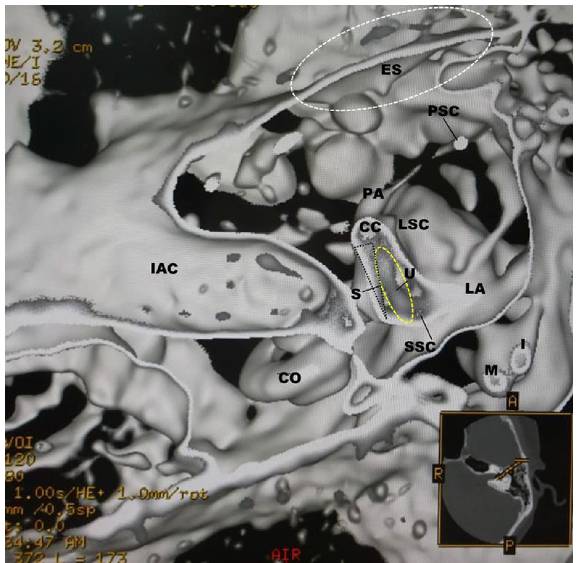
Figure 6. MD in a 58-year-old female. In the axial view, the utricular macula (yellow dotted oval) is in the shape of an elongated pea and connected to the exit of the lateral semicircular canal. The expanded saccular macula (black dotted triangle) is visible from the superior axial view. U utricular macula (yellow dotted oval), S saccular macula (black dotted triangle), LA lateral ampulla, LSC lateral semicircular canal, PA posterior ampulla, PSC posterior semicircular canal, SSC superior semicircular canal, CC common crus, ES endolymphatic sac (white dotted oval), CO cochlea, IAC internal auditory canal, M malleus, I incus.